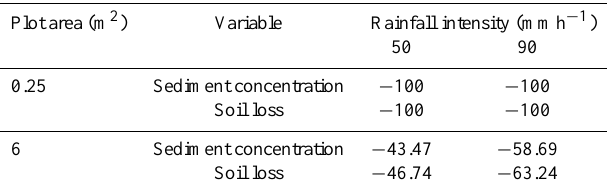
Table 4. Reduction rates (%) in average sediment concentration and soil loss in plots treated with rice straw